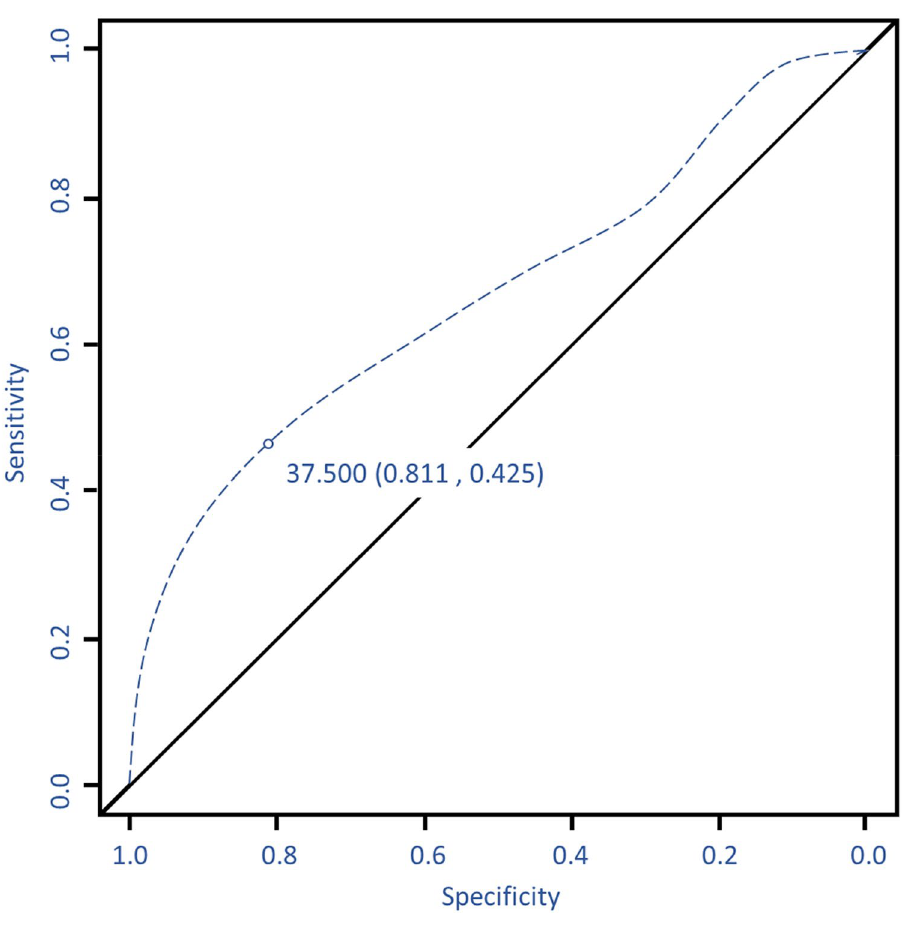
Figure 4. Abdominal fascial defect cutoff value for risk of donor related complication. 37.5 cm 2 value contained estimated sensitivity of 0.81 and specificity of 0.43. R program version 3.6.3 (The R Foundation for Statistical Computing, Vienna, Austria) was used in creating diagram.